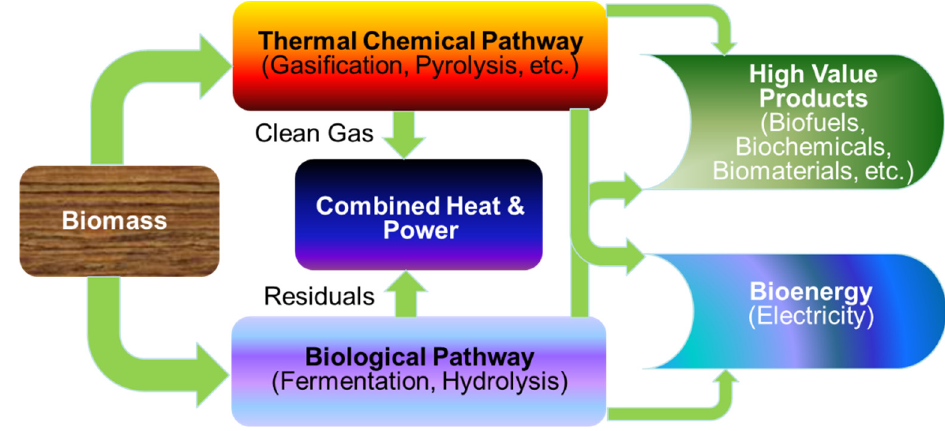
Figure 1. The integrated biorefinery concept.